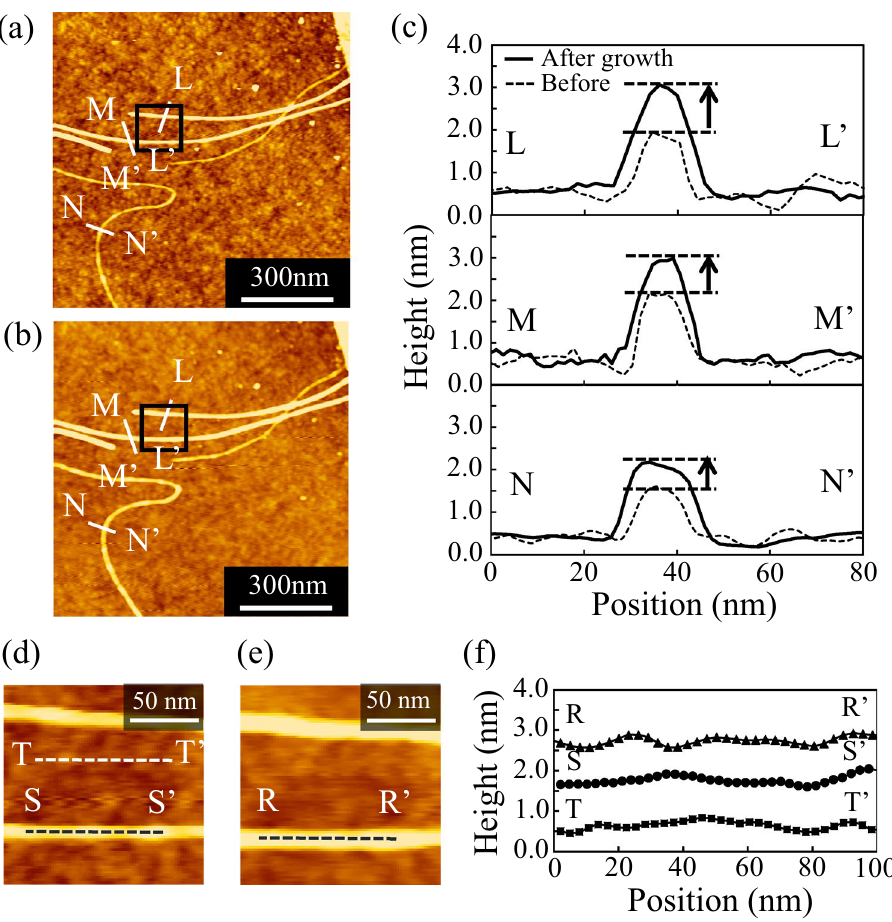
Figure 1. AFM images of GNRs ( a ) before and ( b ) after CVD growth, and ( c ) height profiles along L–L ′ , M–M ′ and N–N ′ lines, respectively. ( d , e ) are the enlarged AFM images obtained from the squares in ( a,b ). ( f ) is the surface roughness on the grown GNR and SiO 2 /Si substrate along S–S ′ , R–R ′ and T–T ′ lines, respectively. The AFM images are edited using a software AFM5000/AFM5010 Ver. 6.03A (C) Hitachi High-Tech Science Corp.